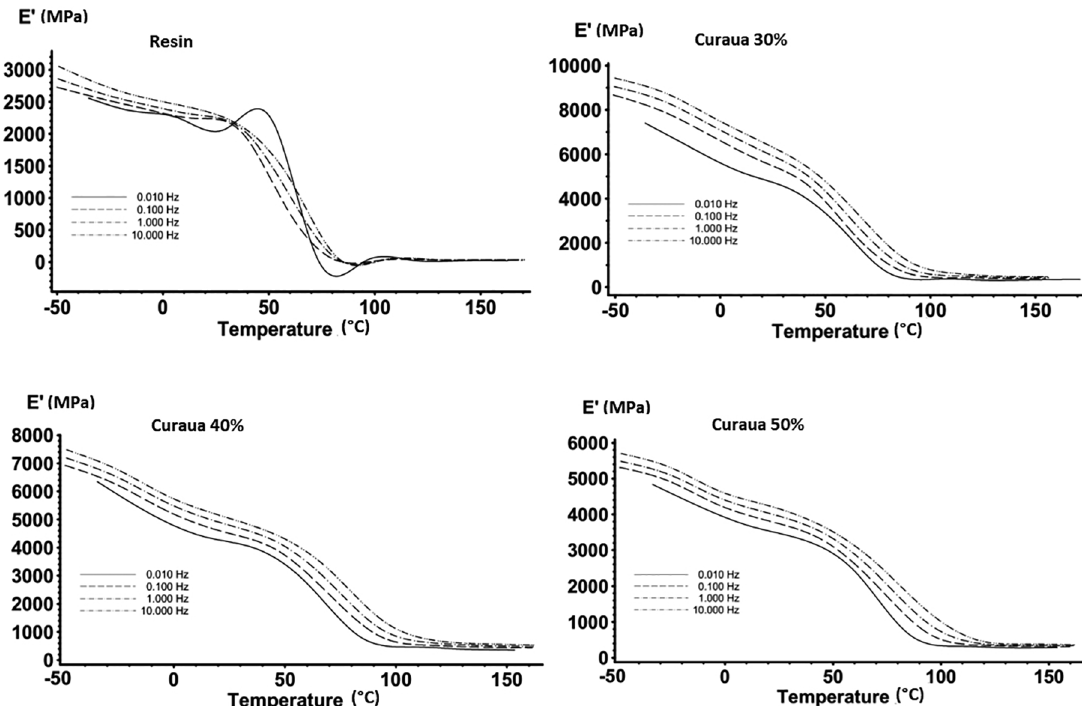
Figure 6. Curaua/Epoxy composites storage modulus (E') at different